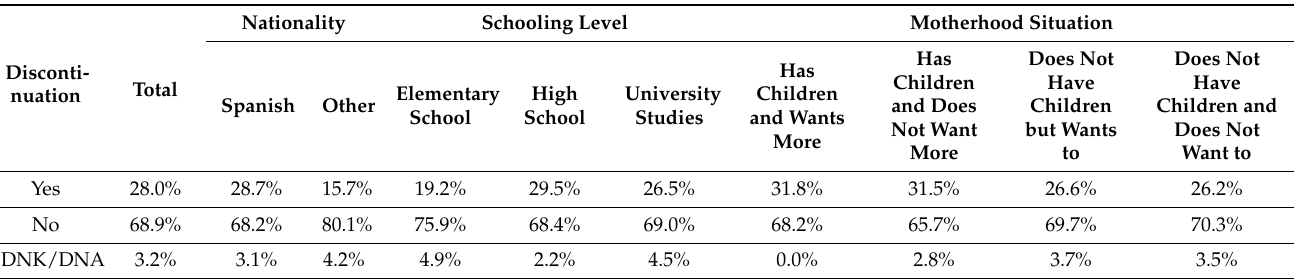
Table 5. Discontinuation in the use of contraceptives according to nationality, schooling level and desire to conceive fulfilled.